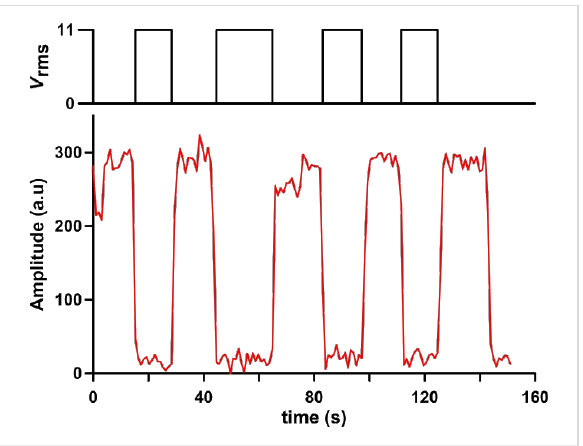
Figure 5: Raman G-band amplitude variation (below) during a driving voltage sequence between 0 and 11 V rms (above).